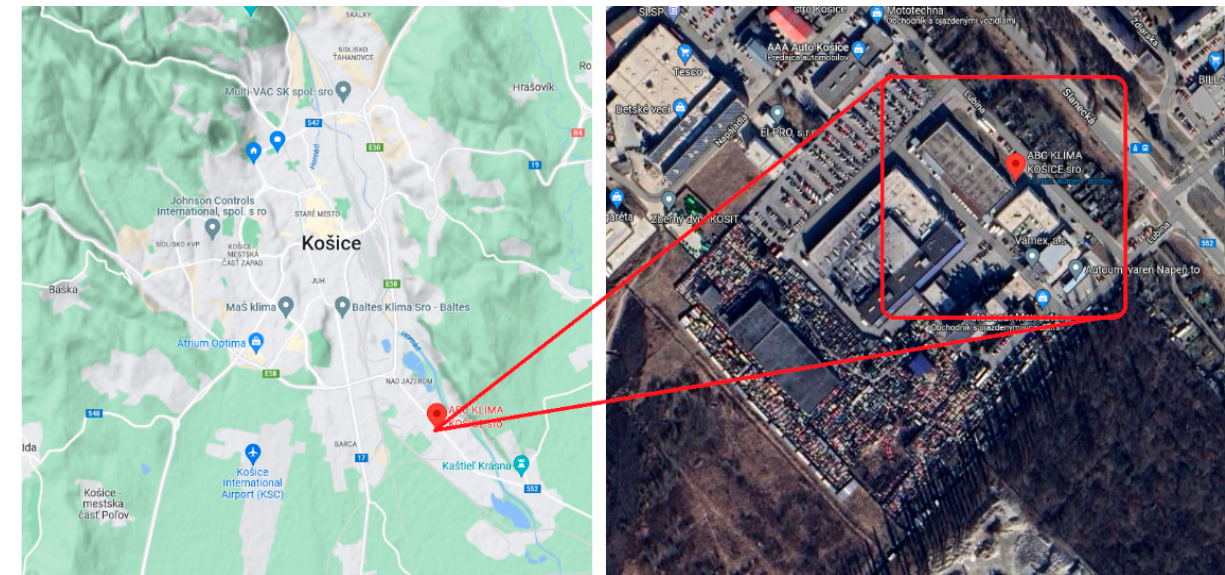
Figure 1. Situation of the object.